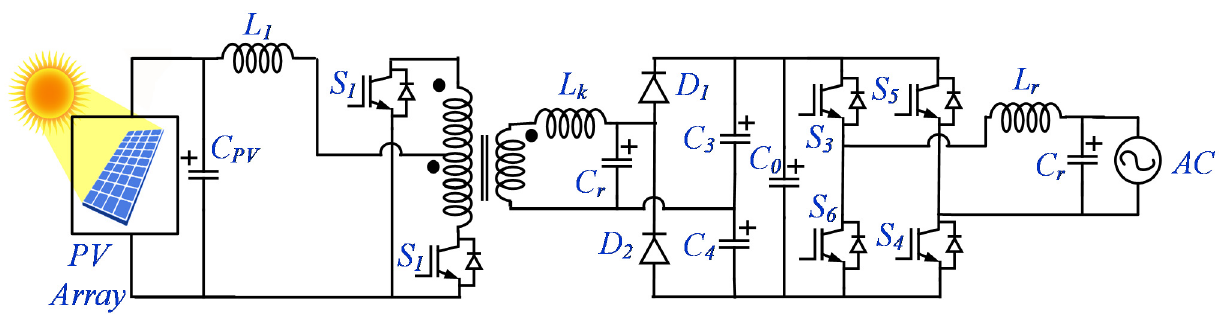
Figure 33. Current fed push-pull converter with full bridge inverter. The parallel capacitor and transformer secondary leakage reactance form an LC res- onance circuit. Soft-switching is achieved by turn-on ZVS and turn off ZCS for certain operating conditions. This system has an efficiency of 97.5% at high power. In Figure 34 authors proposed the new Hybrid resonant DC-DC converter with soft switching. Hybrid DC–DC converter consisting of bi-directional GAN switch parallel to the high-frequency transformer and DC link capacitors [60].